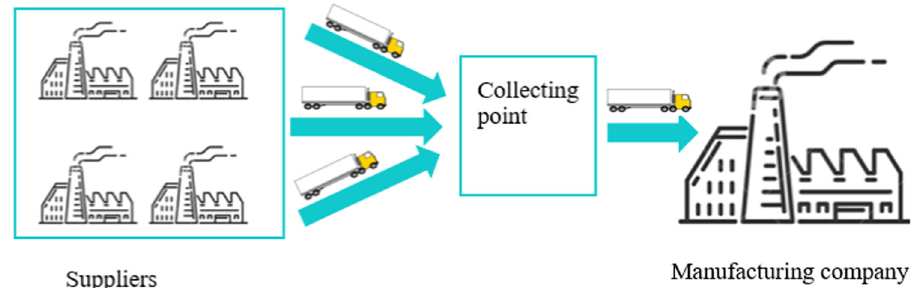
Figure 3: Transport to the collecting point. Own source.